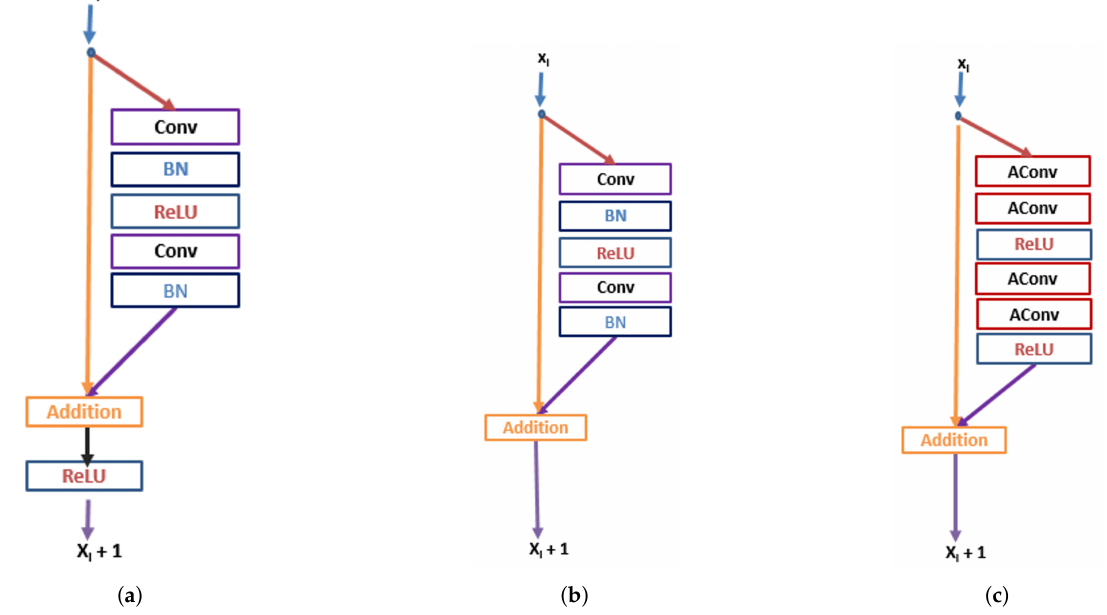
Figure 2. The comparison design of residual connection blocks [49] with our proposed residual block. ( a ) Original residual neural network (ResNet) [34]. ( b ) SRResNet [19]. ( c ) Proposed. BN = batch normalization; AConv = asymmetric